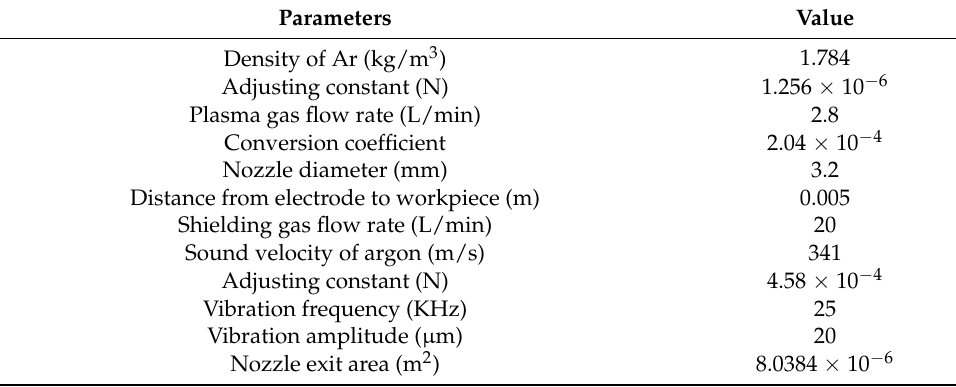
Table 1. The used welding